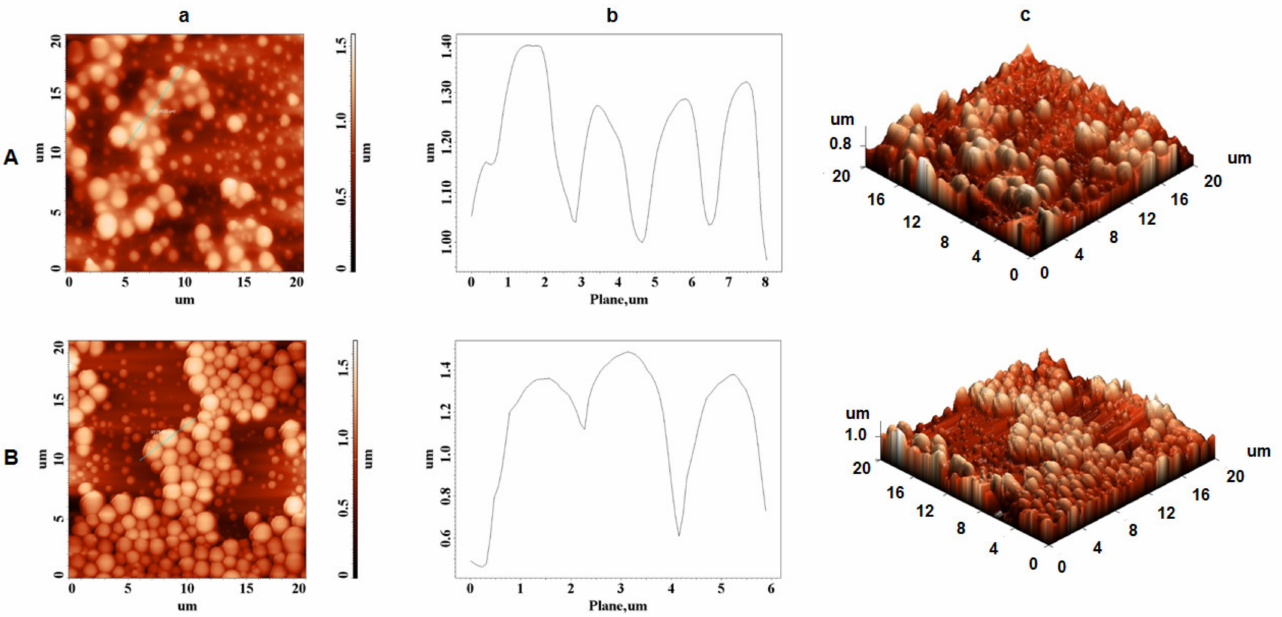
Figure 4. AFM images of extracted zein using ultrasonic homogenizer; ( A ) 65/250 (65% ethanol solution and 250 µ m flour granulation) and ( B ) 65/710 (65% ethanol solution and 710 µ m flour granulation); ( a ) height AFM images; ( b ) plot height distribution of particles along the profile line and ( c ) 3D AFM